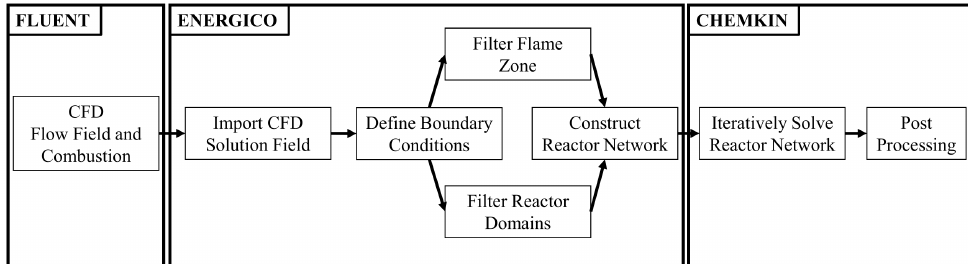
Figure 1. Tool chain of the ERN setup and solution approach. CFD flow field and combustion data are used to filter the ERNs, based on the local temperature and flow composition. The filtered field is then translated into network models with different degrees of detail (number of reactor modules). The system is iteratively solved in the Ansys Chemkin program, which can also be used for data postprocessing. Another distinct novelty of the presented work is the application to FLOX ® combus- tion. FLOX ® burners operate in a MILD (moderate or intense low oxygen dilution) regime. They were first applied in atmospheric, low calorific furnace applications [36,37]. The FLOX ® principle, as adapted for gas turbine combustion, is illustrated in Figure 2.